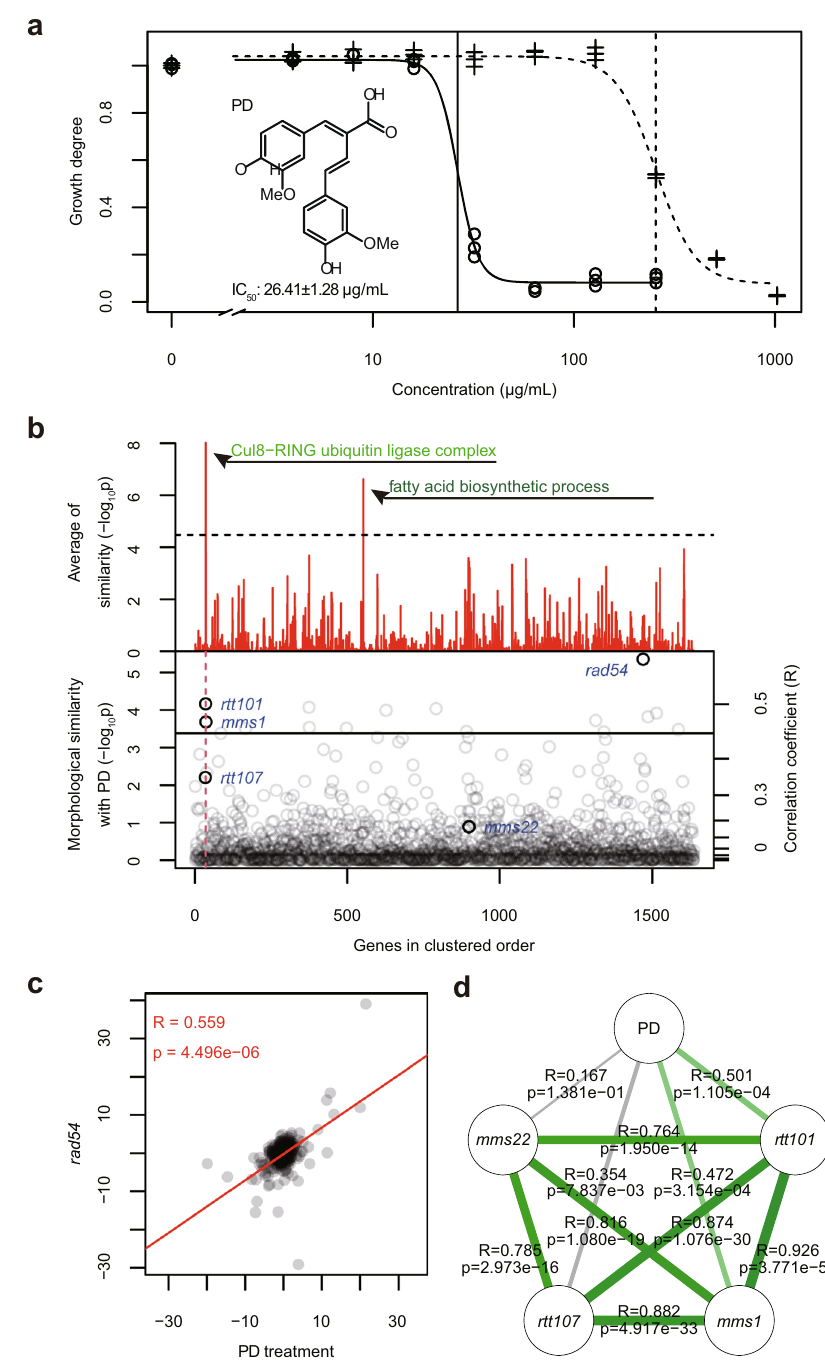
Fig. 6 Prediction of the intracellular target of poacidiene. a Growth inhibition of yeast strain (3 Δ ) by poacidiene (PD) and poacic acid (PA). The solid curve with circles and the dashed curve with plus symbols indicate approximated logistic curves of PD and PA, respectively. Vertical lines indicate IC 50 values estimated by logistic regression (PD: 26.41 ± 1.28 μ g/mL, PA: 255.2 ± 7.8 µg/mL, mean ± standard error). b Morphological similarity of PD-treated cells with 1637 quadruple mutants. Legends are the same as Fig. 4a. Enriched GOs in the detected gene groups ( p < 0.05 after the Bonferroni correction by likelihood ratio test) are listed in Supplementary Data 15. Signi fi cantly similar mutants (FDR = 0.05 by one-sample test with Gaussian distribution fi tted to the t-distribution of correlation coef fi cients from the wild type) are listed in Supplementary Data 14. c Similarity of morphological pro fi les between the PD-treated cells and rad54 Δ . Legends are the same as Fig. 4c. d Similarity of the morphological pro fi les among PD-treated cells (PD) and Cul8-RING gene-deletion mutants. Green lines (but not grey) indicate signi fi cantly high correlation coef fi cients at FDR = 0.05. R and p indicate the Pearson product-moment correlation coef fi cient and p -value calculated by one-tailed t-distribution,